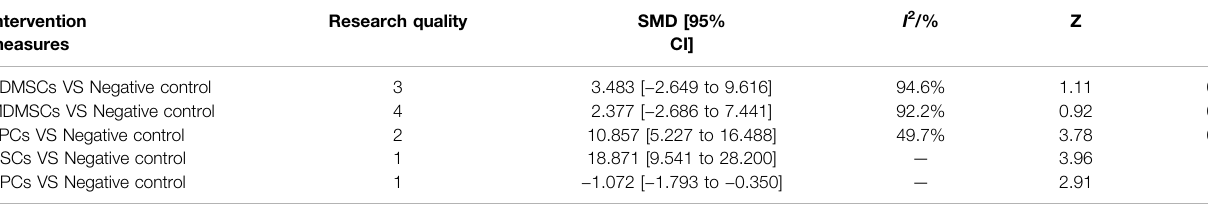
TABLE 11 | Traditional Meta-analysis results of blood urea nitrogen level between stem cell groups and the control group at 14 days after administration. Intervention measures